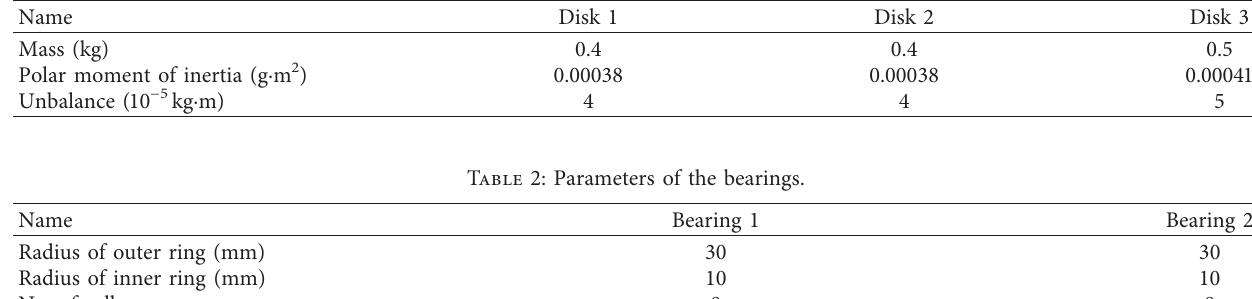
Table 1: Inertial properties and unbalance configuration.